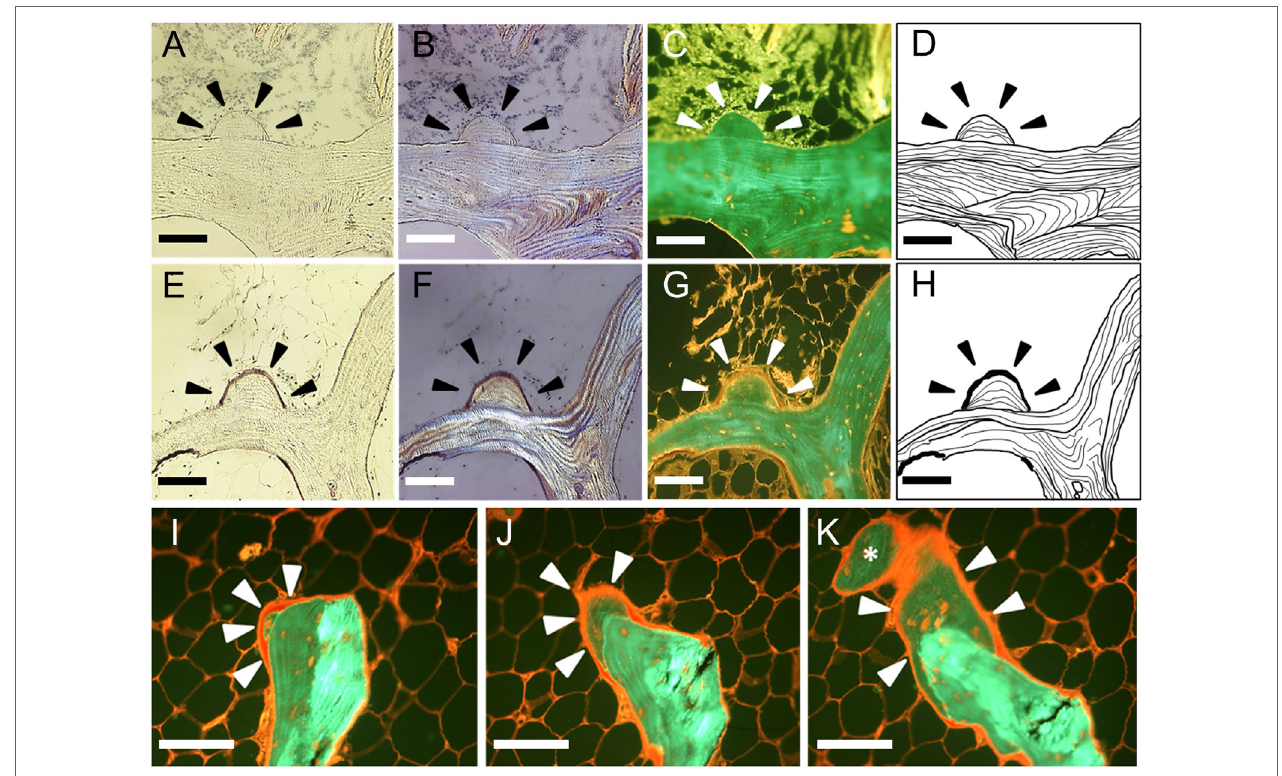
FigUre 2 | Histological findings in minimodeling with and without osteoid seam. A minimodeling structure (MiS) without an osteoid seam (a–D) . Arrowheads indicate the representative MiS. The base of the MiS is a smooth lamellar bone surface without any evidence of previous osteoclastic Howship’s lacunae. The lamellar pattern of the base is different from that of the MiS. A forming minimodeling structure (FMiS) (e–h) . An osteoid seam was detected on the MiS surface as purple under polarized light microscopy [ (F) , arrowheads], and red under fluorescent microscopy [ (g) , arrowheads]. The degree of fluorescent signal in the FMiS was lower than that of the base (g) . An analysis of consecutive sections [ (i–K) ; I → J → K]. An FMiS was detected on the smooth bone surface without evidence of previous bone resorption (i) , which showed growth (J) and connection to the adjacent trabecular bone as indicated by an asterisk (K) . Bright-field microscopy (a,e) ; polarized light microscopy (B,F) ; fluorescent microscopy (c,g,i–K) ; diagram of the MiS (D,h) . Scale bars: 100